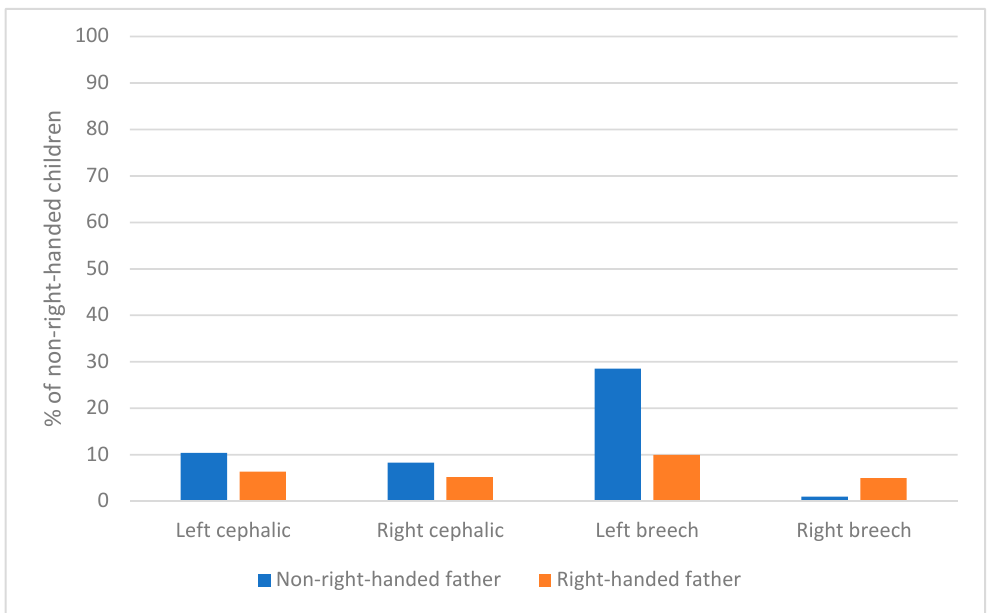
Figure 4. Percentage of non-right-handers at 5 as a function of father’s handedness, presentation and side of position.